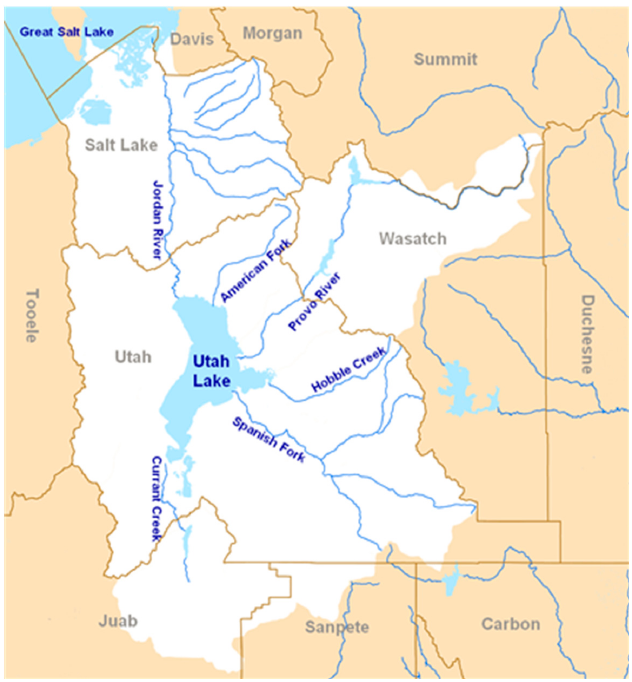
Figure 2. The Jordan River basin that contains both the inflows and outflows for Utah Lake (figure created and data from [41]). Table 1. Hydrologic summary of Utah Lake.